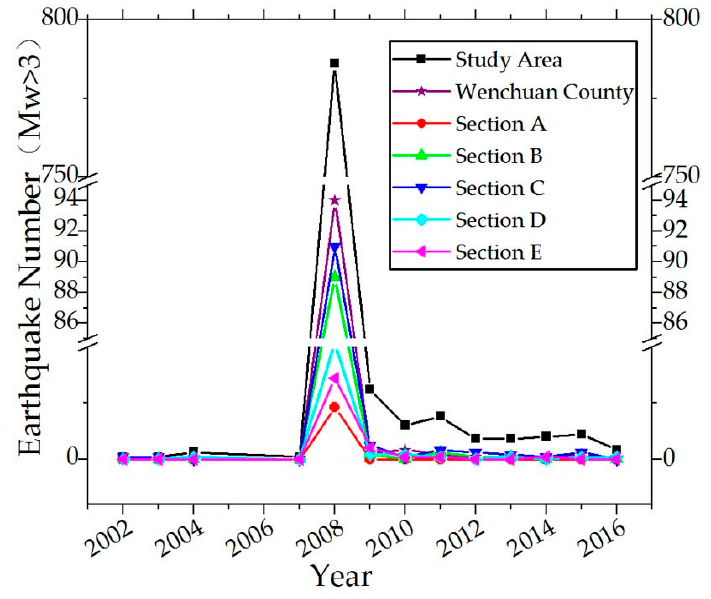
Figure 11. Time series of the annual incidence of earthquakes of Mw >3 in the study area from 2002 to 2016 (Source: USGS).